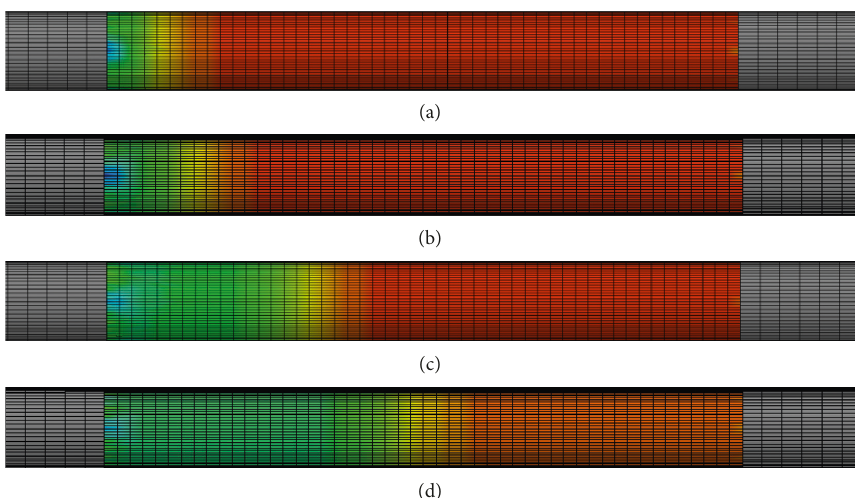
Figure 11: Energy propagation and attenuation in the numerical simulation results: (a) 0.558ms. (b) 0.570ms. (c) 0.600ms. (d) 0.624ms.